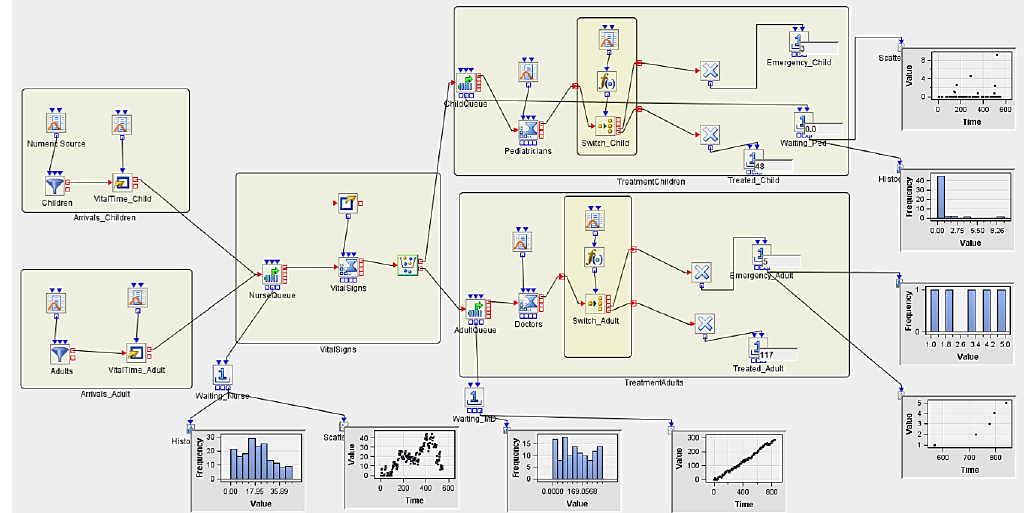
Figure 6. Simulation model when 15 adult patients arrive per hour (no additional staffing).